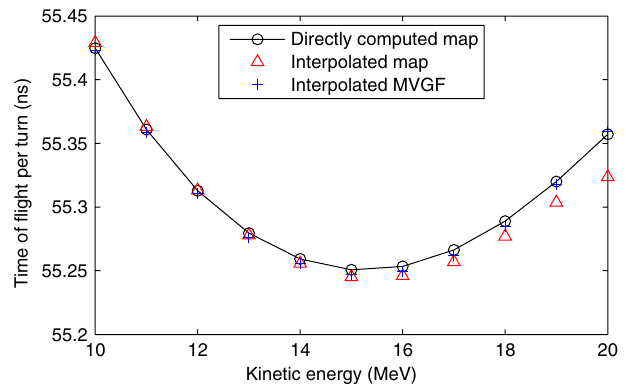
FIG. 14. Variation of time of flight with energy, found from a directly computed map, a map obtained by interpolating the Taylor map coefficients, and a map obtained from interpolation between the MVGF coefficients. The reference energy for all the maps is 14 MeV. We observe good agreement between the directly computed map and the map obtained by interpolating the MVGF.